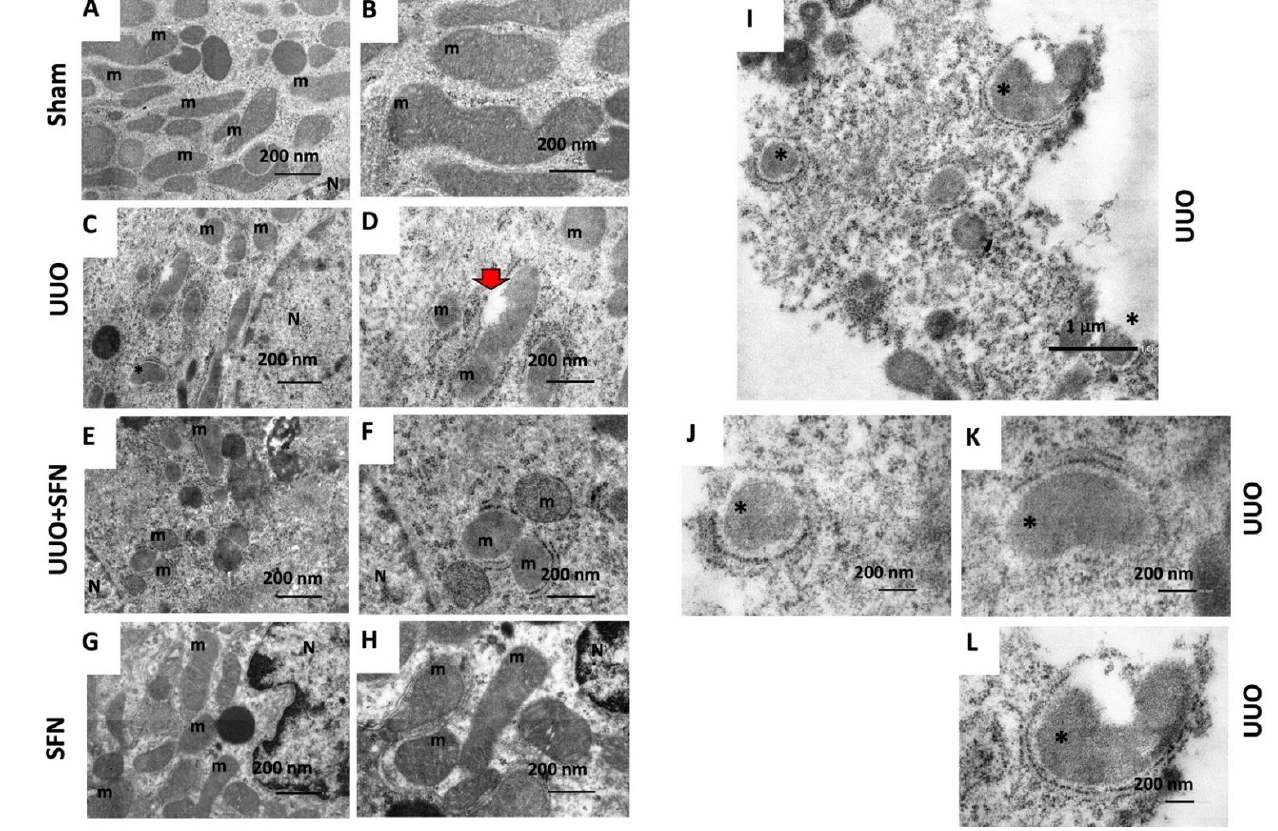
Figure 12. Mitochondrial morphology, autophagy, and mitophagy. The renal cortex was analyzed by TEM to observe mitochondrial distribution and morphology. ( A , B ) Sham. ( C , D , I – L ) UUO. ( E , F ) UUO + SFN. ( G , H ) SFN. m: mitochondria; N: nucleus; asterisks: autophagic bodies; red arrow: mitochondria that have lost the double-membrane continuity. Micrographs in the left column were taken at 10,000× (scale bar = 1 µm) and in the right column at 20,000× magnification (scale bar = 500 nm). N = 3 for sham and SFN groups and n = 4 for UUO and UUO + SFN. Sham: simulated surgery without ligation of the ureter; UUO: unilateral ureteral obstruction with double ligation of the left ureter for seven days; UUO + SFN: UUO treated with SFN (1 mg/kg, intraperitoneal); and SFN: administered with SFN (1 mg/kg, intraperitoneal).